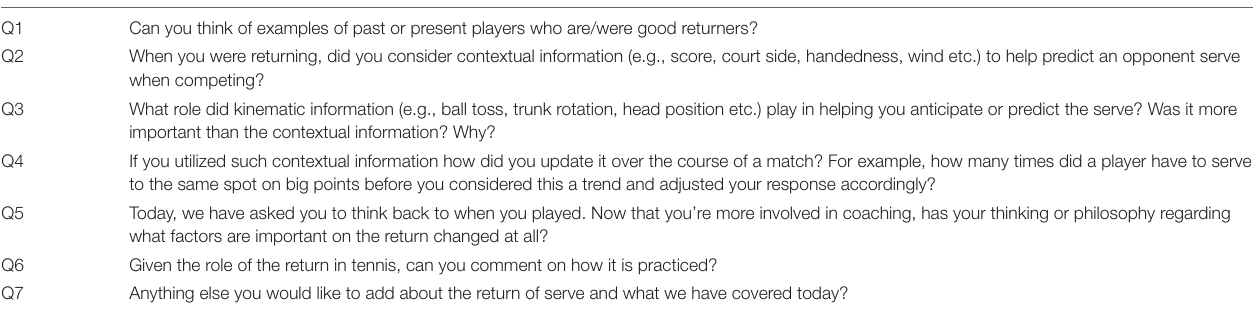
TABLE 1 | Interview guide for participant interview